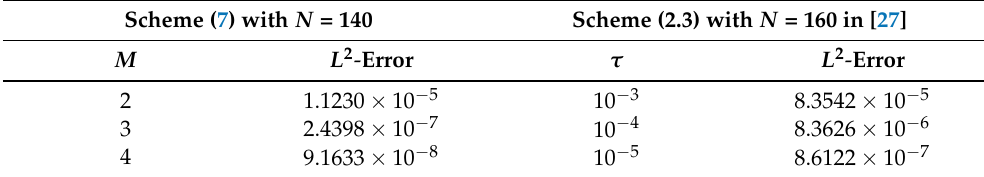
Table 4. Temporal errors at t = 1 for Example 2. Take a = − 40, b = 40, κ = 0.3, x 0 = 0. Scheme (7) with N = 140